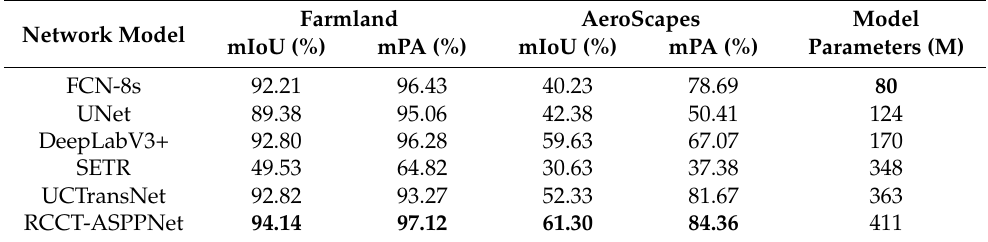
Table 4. Comparison of different